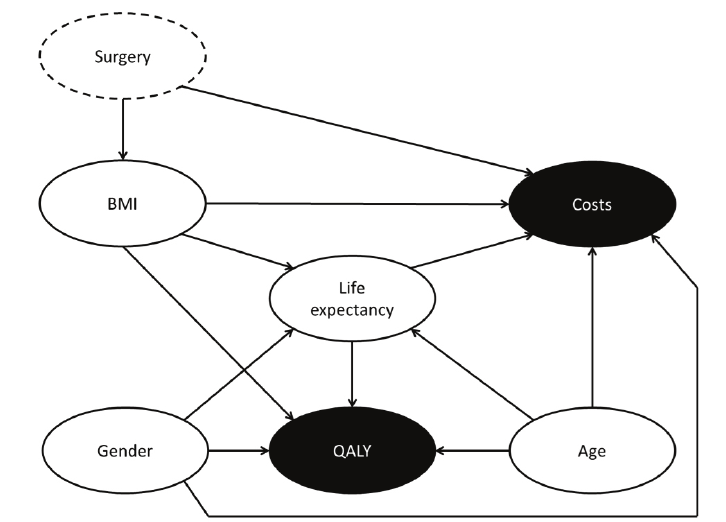
Figure 1: Conceptual model of a person eligible for gastric bypass surgery. Arrows indicate the influence of factors on patient characteristics. Surgery affects Body Mass Index (BMI), which together with age and gender affects life expectancy. Costs and Quality Adjusted Life years (QALY) are derived as a basis for the cost-effectiveness